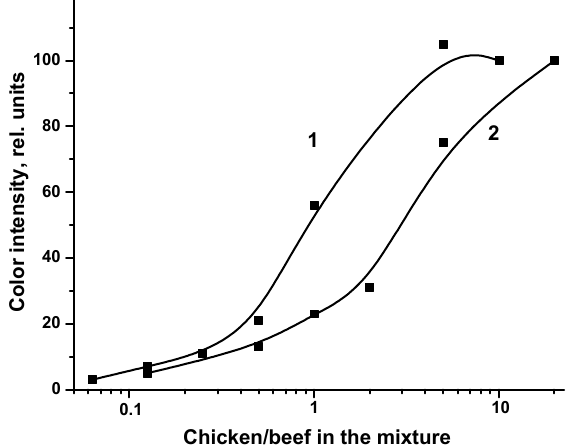
Figure 3. Dependence of the ICA response on the amount (%) of chicken (1) or beef (2) in the meat mixture ( n = 3).